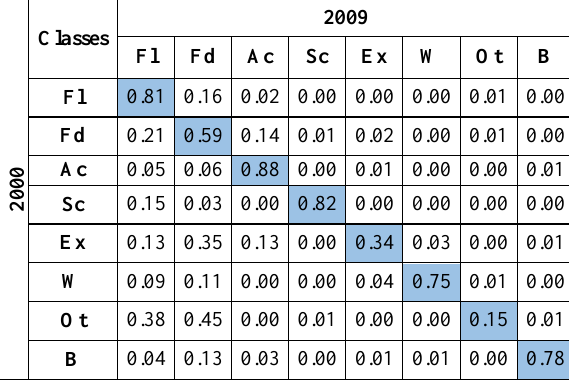
Table 6. Matrix of transition between 2000 to